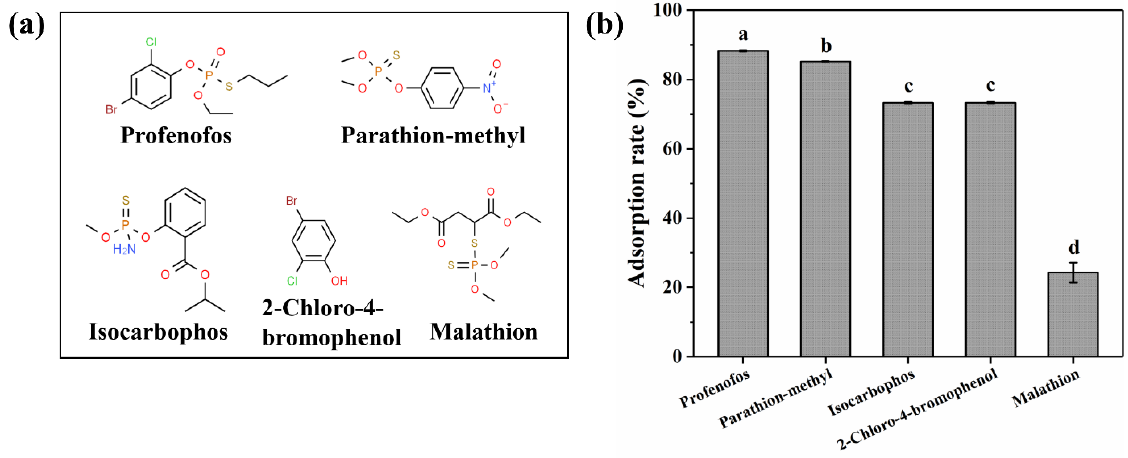
Figure 4. ( a ) Structural formulae of five organic substances; ( b ) removal rate of adsorption of coconut shell biochar for five organic substances. Mean values with the same letter (a, b, c, d) are not significantly different from five organic substances (profenofos, methyl parathion, isocarbophos, 2-chloro-4-bromophenol and malathion) by LSD at the 5% level.